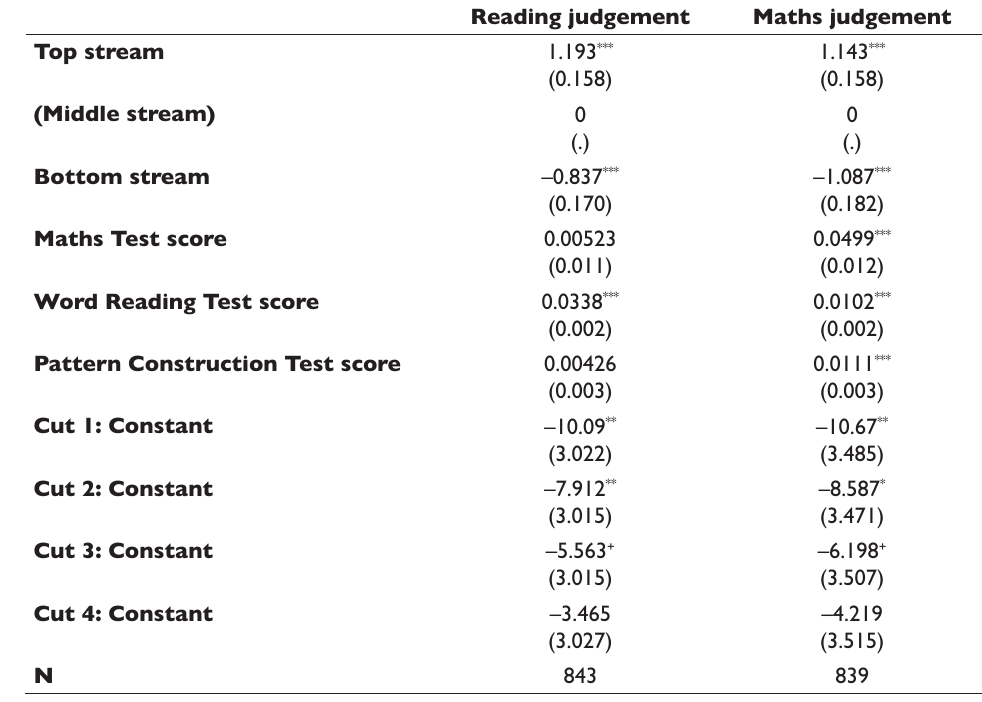
Table 6: Differences in survey-reported teacher judgements of level of reading/maths ‘ability and attainment’ according to pupils’ stream placement (specification six)